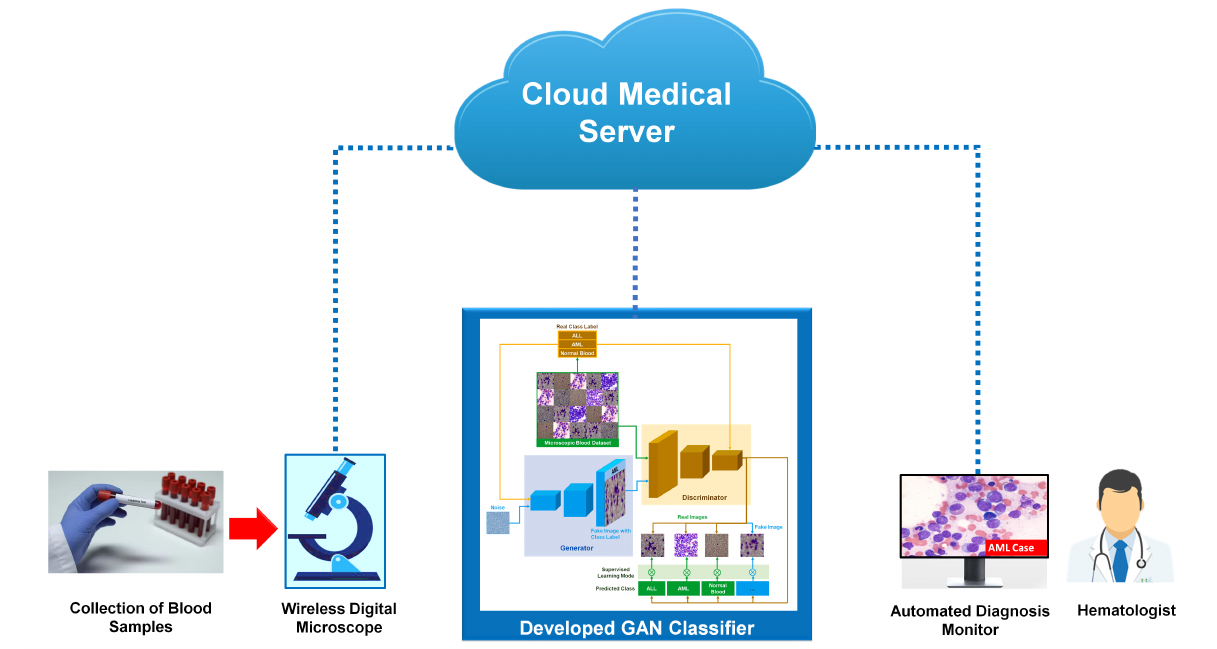
Figure 4. Schematic diagram of our proposed medical IoT-based diagnosis framework for automatic identification of the blood conditions of patients using wireless microscopic imaging of samples and the developed GAN